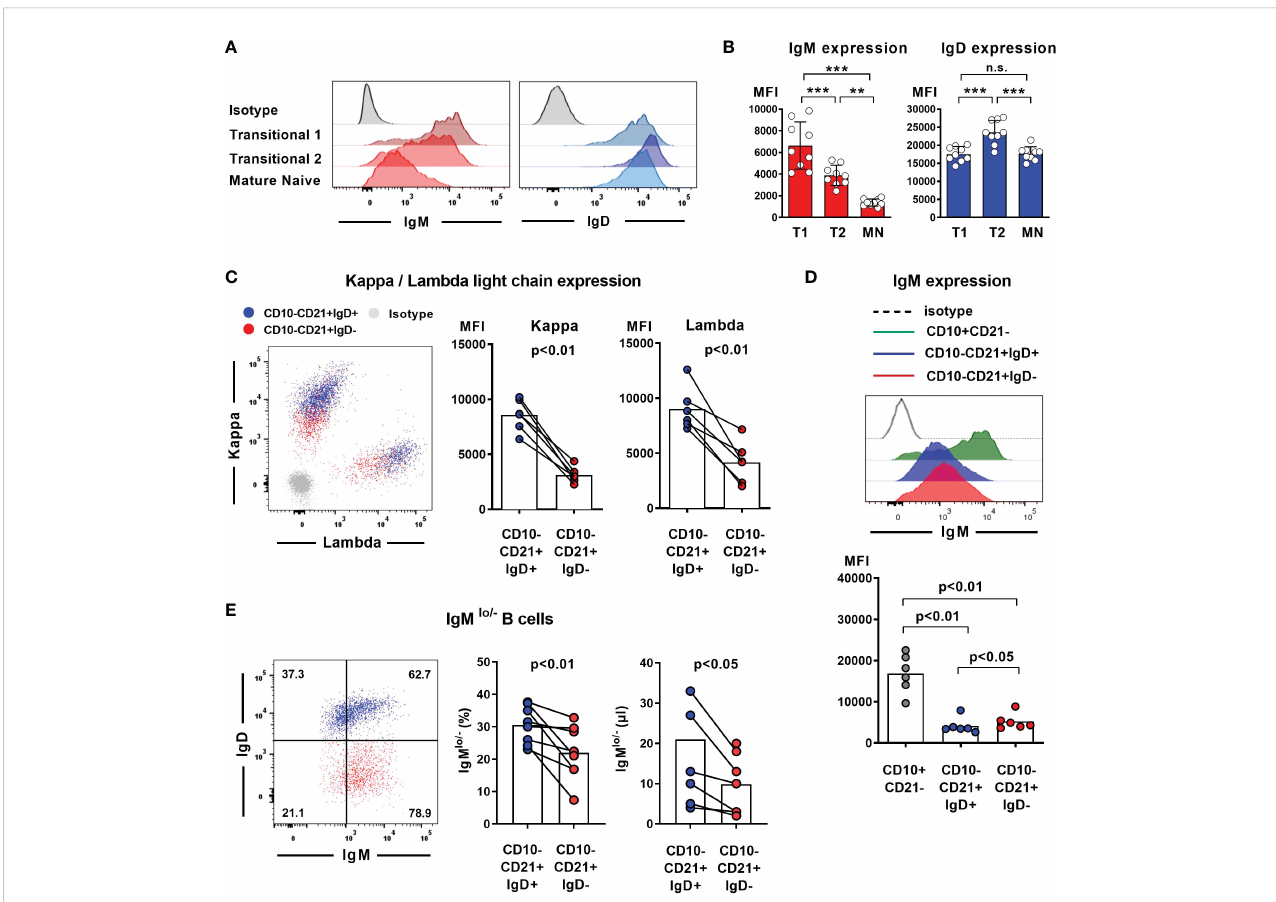
FIGURE 3 Loss of IgD expression is not compensated by upregulation of IgM expression in IgD-negative B cells (A) Representative histograms of IgM and IgD surface expression in different peripheral blood B cell subsets analyzed by fl ow cytometry (CD19 + CD27 - CD10 + CD21 - transitional 1 (T1) B cells, CD19 + CD27 - CD10 + CD21 + transitional 2 (T2) B cells, and CD19 + CD27 - CD10 - CD21 + mature naive (MN) B cells, (B) Compiled fl ow cytometric data of IgM and IgD expression levels (mean fl uorescence intensity, MFI) on different peripheral blood B cell subsets derived from 9 individuals. (**, p < 0.01; ***, p < 0.001; n.s., not signi fi cant; One-Way-ANOVA with Turkey`s multiple comparison test). (C) Representative dot blot showing surface expression of kappa and lambda light chain on IgD-positive (blue) or IgD-negative (red) CD19 + CD27 - CD10 - CD21 + mature naïve B cells. Compiled data on expression levels are shown on the right (paired Student`s t-test). (D) Representative histograms obtained from fl ow cytometric analysis showing IgM expression levels on CD19 + CD27 - CD10 + CD21 - transitional 1 B cells as well as IgD + or IgD - CD19 + CD27 - CD10 - CD21 + mature naïve B cells. Compiled data from 6 individuals carrying different IGHD variants is shown in the lower panel (mean fl uorescence intensity, MFI; One-way ANOVA with Turkey`s multiple comparison). (E) Representative dot blot showing the frequency of IgM lo/- B cells within IgD + (blue) or IgD - (red) CD27 - CD10 - CD21 + mature naïve B cells from an individual carrying a heterozygous IGHD -variant. Compiled data from individuals with different IGHD -variants showing frequencies (left) and absolute counts (right) of IgM lo/- B cells (paired Student`s